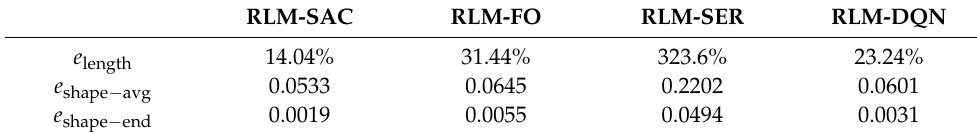
Figure 11. Illustration of the morphing procedure. Each row represents a morphing stage. Table 3. Quantitative comparisons of different morphing